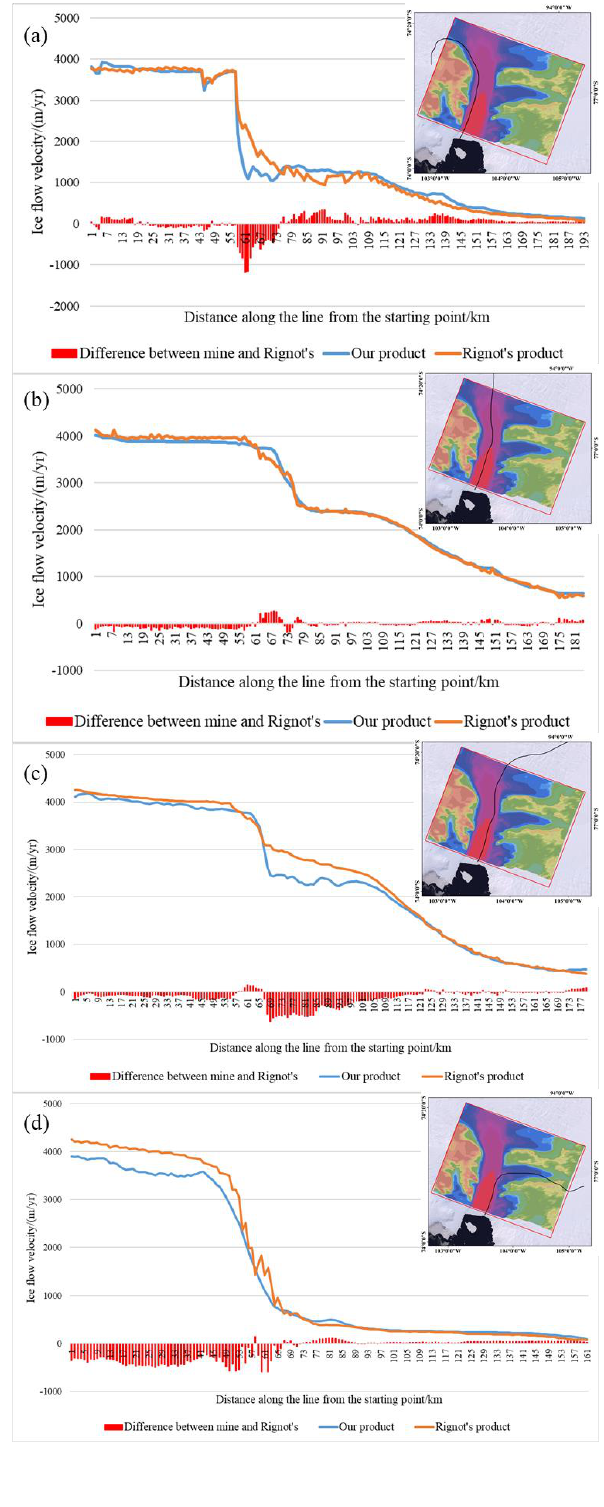
Figure 7 . Velocity comparison diagram of two products on four ice flowlines. The black lines in the figure at the top right represent the distribution of the four flowlines (Liu, 2015),